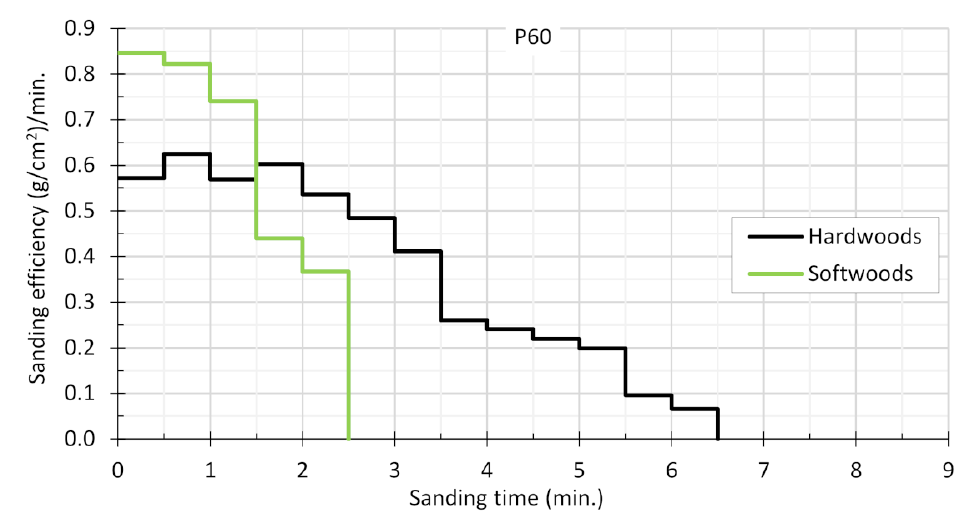
Figure 3. Mean sanding efficiencies of belts with grade P60.